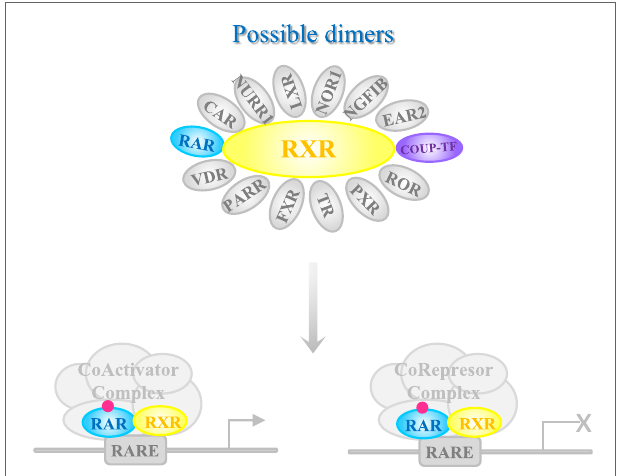
FiGURe 1 | Mechanism of action of RA receptors (RARs). Retinoic acid (RA) nuclear receptor RARs and retinoid X receptors (RXRs) heterodimerize in the presence of the ligand that binds to RAR. The complex interacts with deoxyribonucleic acid containing specific RA responding element sequences [retinoic acid response element (RARE)], to mediate gene transcription. Chicken ovoalbumin upstream promoter transcription factor (COUP-TF) [as others nuclear receptors such as known ligand receptors vitamin D receptor (VDR), peroxisome proliferator-activated receptor (PPAR), liver X receptor (LXR), thyroid receptor, pregnane X receptor (PXR), RAR-related orphan receptor (ROR), and farnesol X receptor (FXR), or orphan receptors BGFIB, Nur77-related receptor 1 (NURR1), nuclear orphan receptor 1 (NOR-1), V-erbA-related protein 2 (EAR-2), and CAR] is able to dimerize with RXR. The complex with COUP-TF inhibits the effect of RA. Depending on the co-factors that are recognized by RAR-RXR complex, transcription of the target gene is activated or